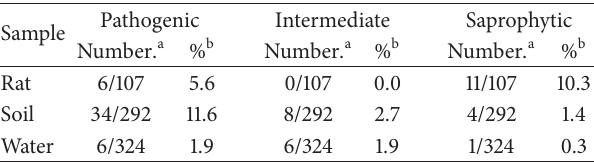
Table 1: Prevalence of Leptospira spp. by PCR in rats, soil, and water samples collected in this study.